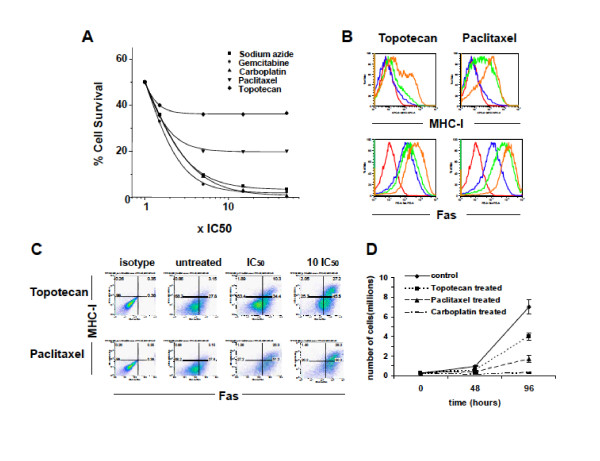
Topotecan and paclitaxel upregulate MHC-I and Fas on ID8 cells and exert their cytotoxic effects in a phase-specific manner. (A) Cytotoxic effects of paclitaxel, gemcitabine, topotecan, carboplatin or control sodium azide on ID8 tumor cells. ID8 cells were incubated with the chemotherapeutic agents for 6 hours. Survival fraction 42 hours later versus concentration (IC50 is used as unit) is shown. Curves are sigmoidal and for the same time of exposure (6 hours) they plateau at a level that depends on the cell cycle specificity. For topotecan and paclitaxel the plateau level is > 30% and > 20% respectively, indicating significant phase specificity. For carboplatin and gemcitabine the sigmoidal curve plateaus at a level < 2.5%. The sigmoidal curves represent the fit of the obtained data to a logistic regression dose response curve. The killing curve of sodium azide (chemical, no interfering with the cell cycle) was used as a negative control. (B) Upregulation of MHC-I and Fas on viable ID8 cells treated with topotecan (left) or paclitaxel (right). Cells were exposed to the drugs for 6 hours, washed and incubated in drug free media for 42 hours before harvesting and staining with MHC-I and Fas antibodies. Isotype control (Red); untreated (Blue); Drug concentration inducing approximately 50% killing (IC50; Green); Drug concentration corresponding to the plateau of the dose response curve (10 fold IC50; Brown). All the histograms depict Annexin-V negative (non apoptotic) cells. (C) Dot plot diagrams depicting the upregulation of MHCI and Fas in non-apoptotic tumor cells exposed to Topotecan (upper) and Paclitaxel (lower) at IC50 or 10 fold IC50 for 6 hours 2 days before. (D) Growth curve of sorted MHC-I positive ID8cells following treatment with topotecan, paclitaxel and carboplatin, as indicated. Error bars represent interquartile range (25-75%).